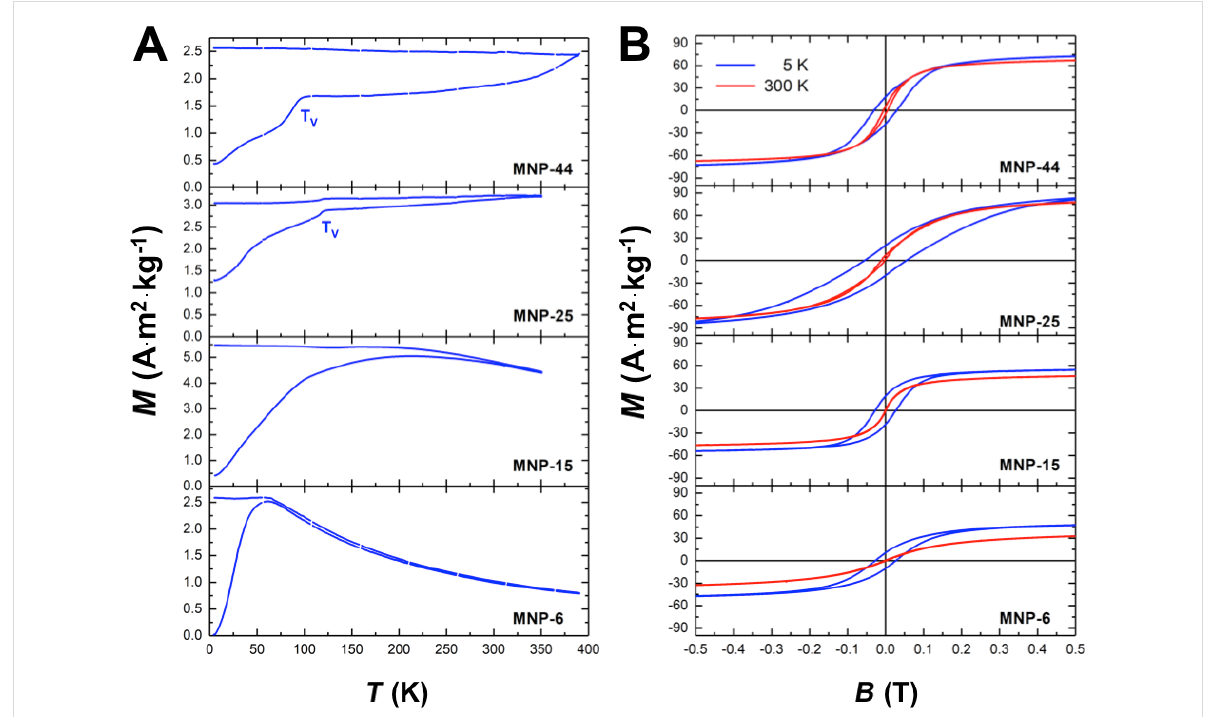
Figure 4: Magnetic properties of Fe 3 O 4 –Au hybrid NPs. ZFC/FC curves at B = 5 mT (A). T V indicates the Verwey transition temperature for samples MNP-25 and MNP-44. Hysteresis loops at T = 5 K and T = 300 K